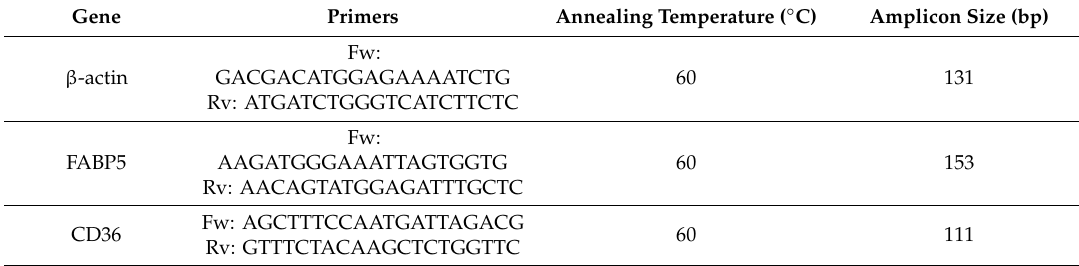
Table 1. Primers used for